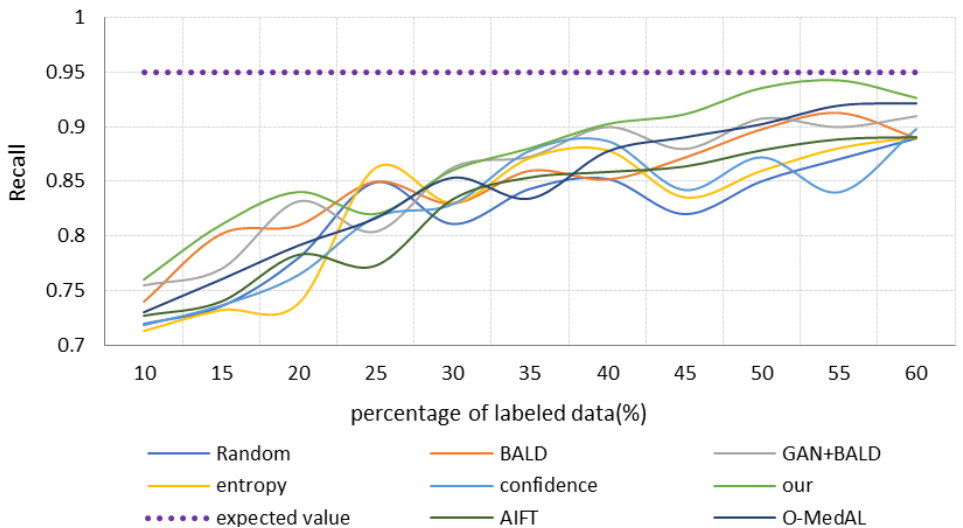
Figure 9. Recall with the increase of iterations.